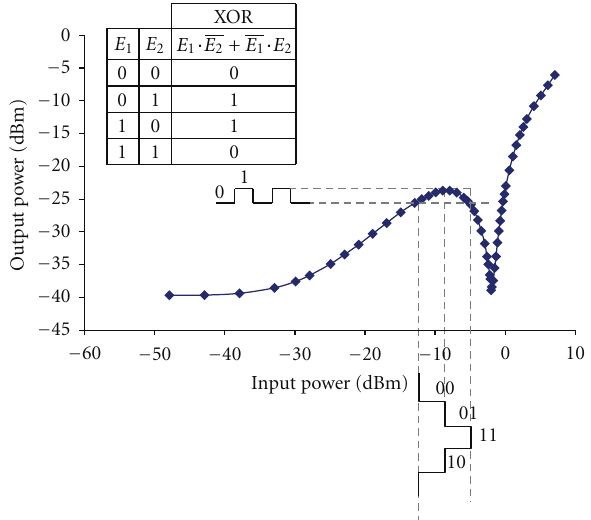
Figure 8: Measured static transfer function and principle of ope- ration for XNOR function at a blocking power equal to − 2 dBm and wavelength equal to 1550